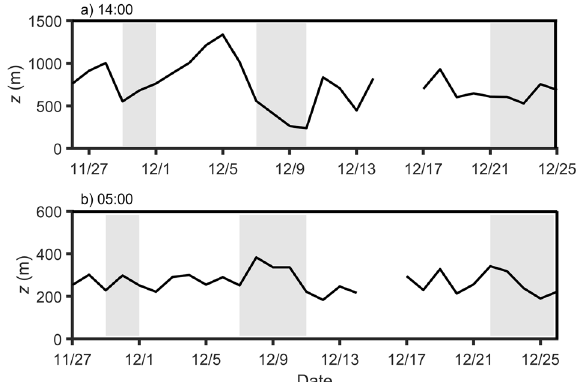
Fig. 7 Temporal variations of the average atmospheric boundary layer height of six observation stations during the observation period. a 14:00 LT and b 05:00 LT. The shaded areas represent three haze